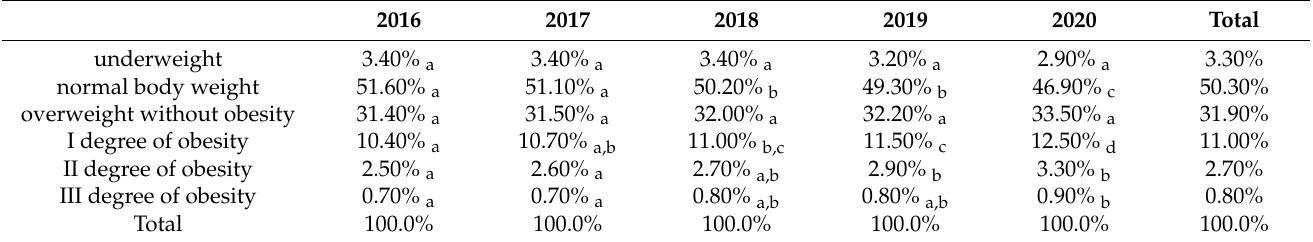
Table 1. Body mass index (BMI) distribution depending on the year of measurement.